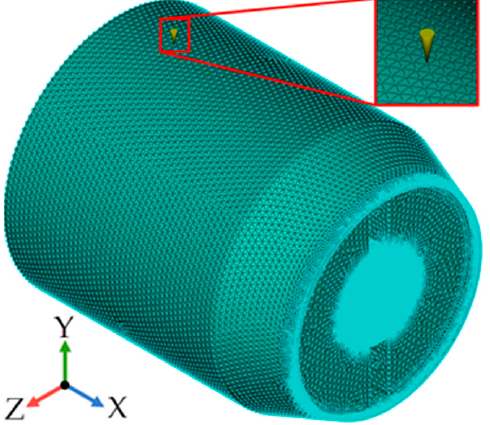
Figure 2. Geometric models used in pouring simulation: ( a ) end fitting model; ( b ) resin cavity model; ( c ) steel wire bending pattern.